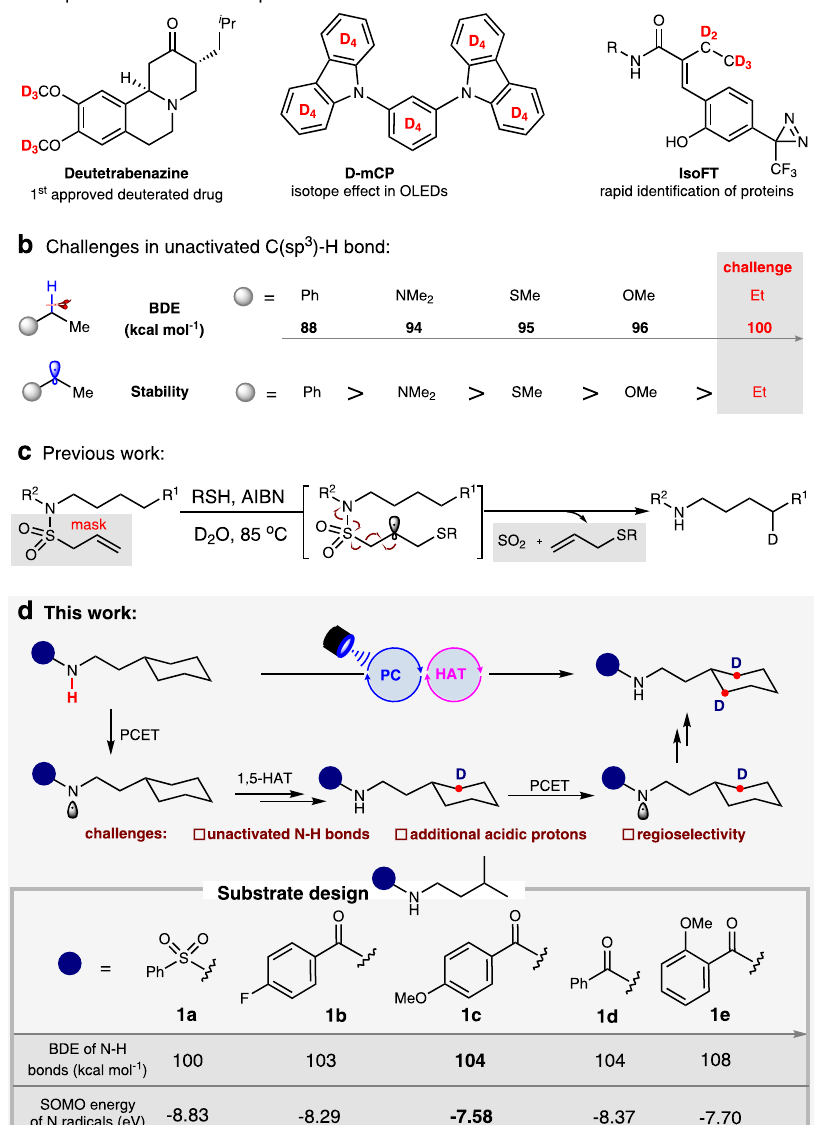
Fig. 1 Project background and design plan for radical deuteration of unactivated C(sp 3 ) bonds. a The signi fi cance of deuterated compounds. b The BDE of different C(sp 3 )-H bonds and stability of related alkyl radicals. c Previous work on N-X bonds cleavage induced deuteration of remote C(sp 3 )-H bonds. d This work: Tunable H/D exchange of single or multiple unactivated C(sp 3 )-H